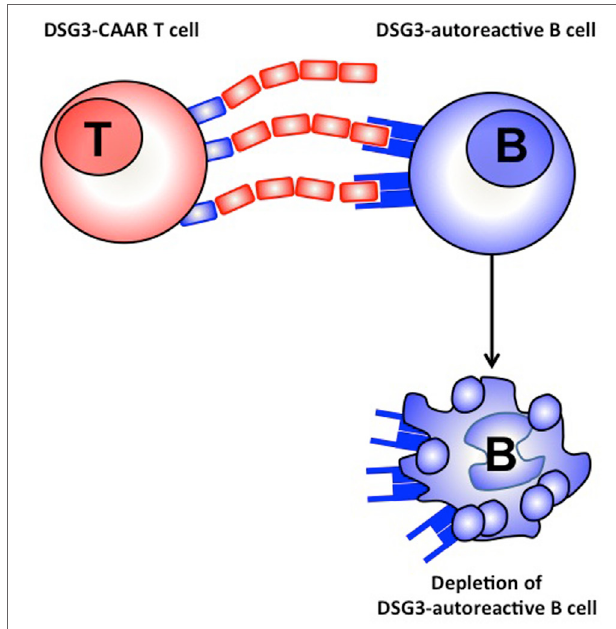
FiGURe 2 | Chimeric auto antibody receptor (CAAR) T